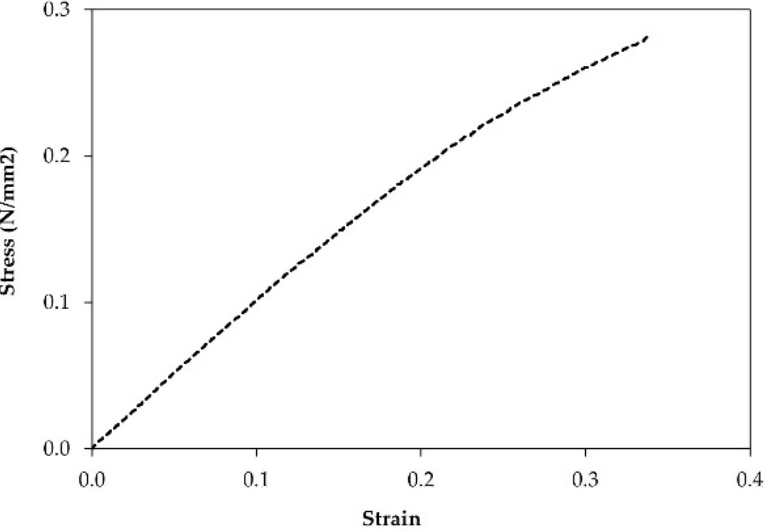
Figure 10. Representative stress-strain curve from the flexural test of the natural rubber foam.